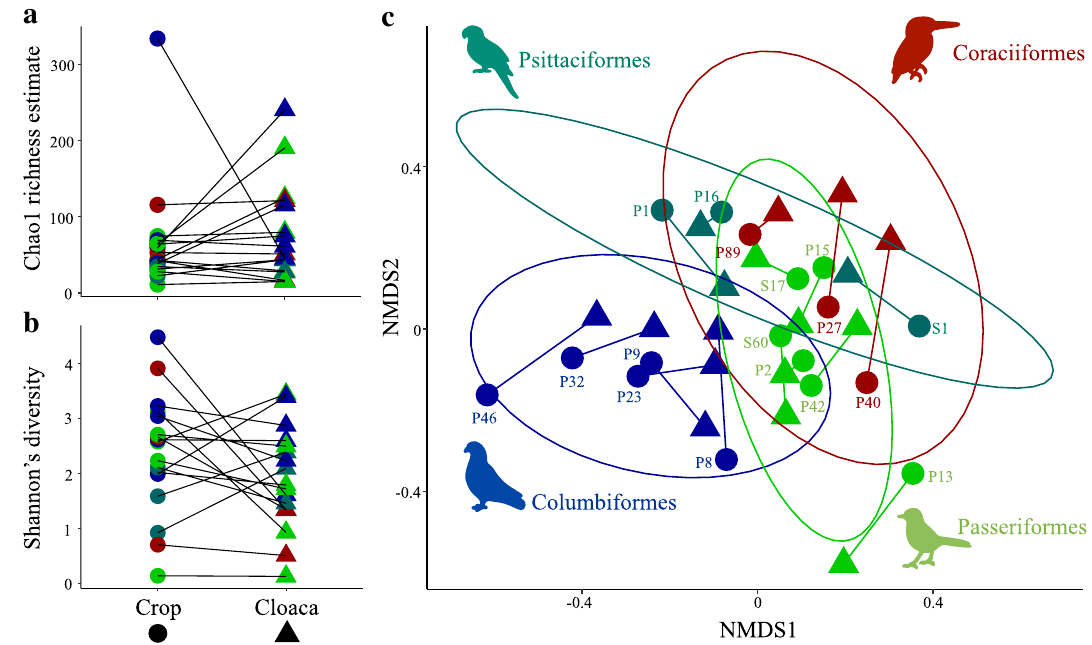
Figure 5. Alpha diversities did not differ between crop and cloacal microbiomes, but beta diversities demonstrated a host order-level effect. Chao1 richness estimate ( a ) and Shannon’s diversity index ( b ) of microbiomes in the two regions of the digestive tract. Microbiomes of the same bird individual are connected with a line. ( c ) The NMDS plot (stress = 0.2243) represents the microbial community similarity (measured with Jaccard dissimilarity index) of the cloacal and the crop microbiomes. Individual IDs are given near the crop samples and points are coloured according to the host order. Ellipses represent the 95% confidence